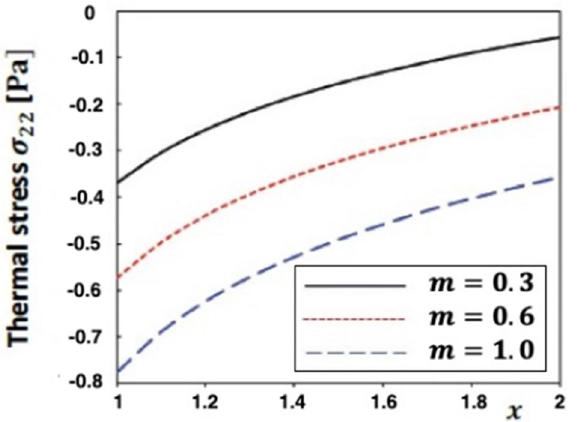
Figure 8. Variation of the thermal stress σ 22 along x -axis for different values of functionally graded parameter.